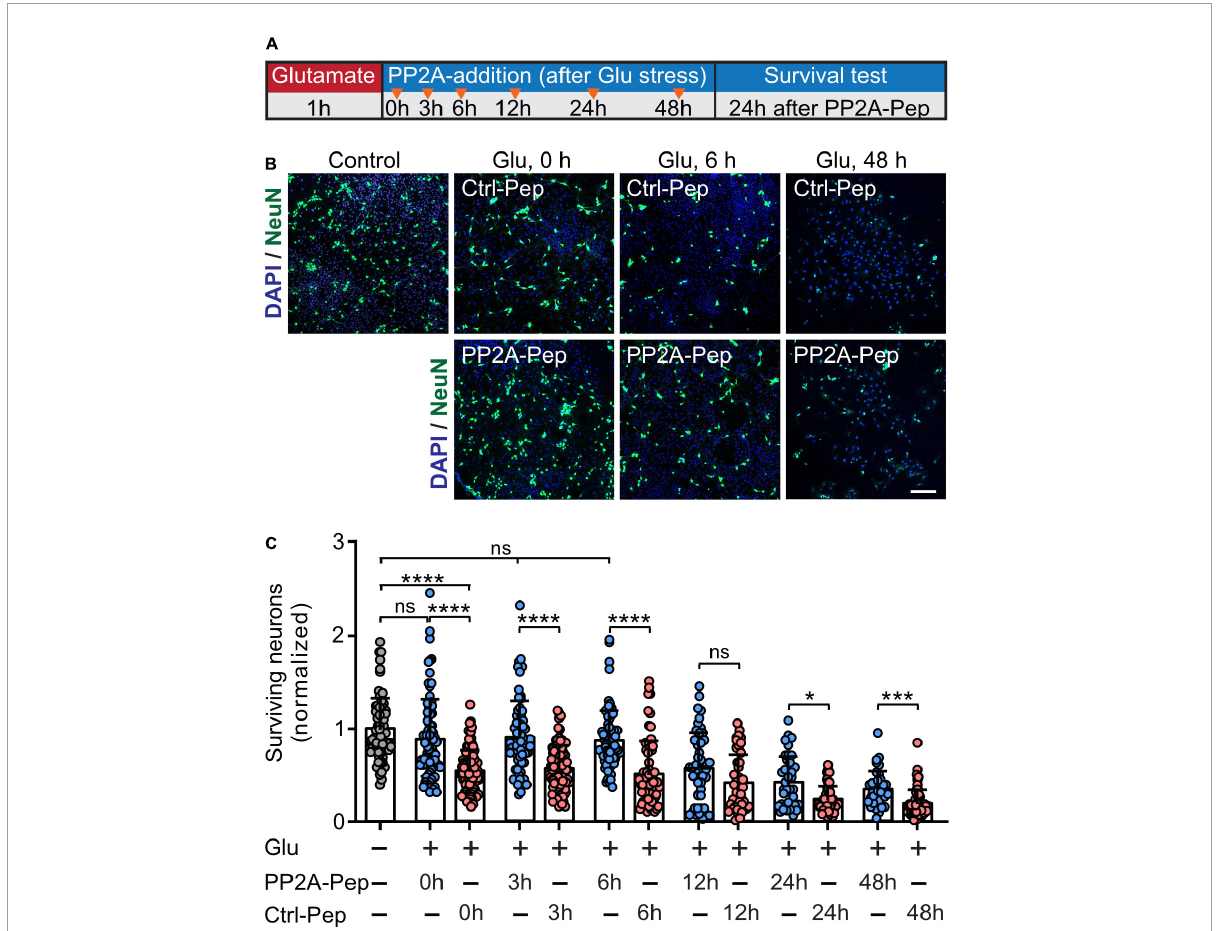
FIGURE6 PP2A-Pep inhibits progressing excitotoxic neuronal death. Neurons were stressed for 60 min with 50 µ M glutamate and treated with no peptide (control), PP2A-Pep (10 µ g/ml) or Ctrl-Pep (10 µ g/ml) 0, 3, 6, 12, 24, and 48 h after the glutamate stress. After additional 24 h of incubation, the cultures were stained with DAPI for total cells (glia plus neurons) and with an antibody directed against NeuN for neurons. (A) Schematic representation of the experimental design. (B) Representative images (scale bar: 100 µ m) are shown for the untreated control and for the condition where the peptides were immediately administered after the glutamate stress (0 h), or after 6 and 48 h. (C) Quantification of neuronal loss. Number of neurons were normalized to the untreated control cultures. The data represent the mean ± SD of 35–112 frames (fields of view) per experimental condition from three independent experiments. Brown–Forsythe and Welch ANOVA with Games Howell’s multiple comparison test (ns, p > 0.05, * p < 0.05, *** p < 0.0005, **** p < 0.0001).